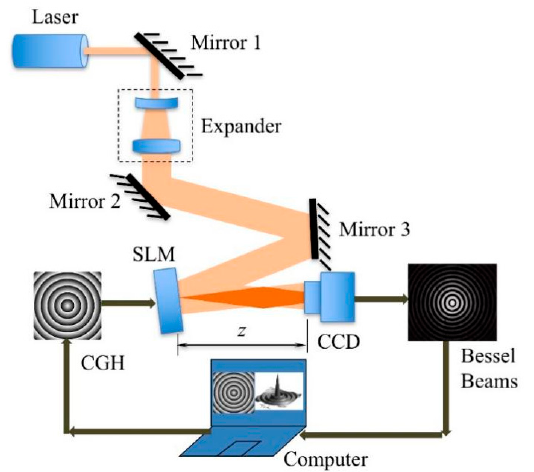
Figure 5. Experimental setup for generating positive axicon.